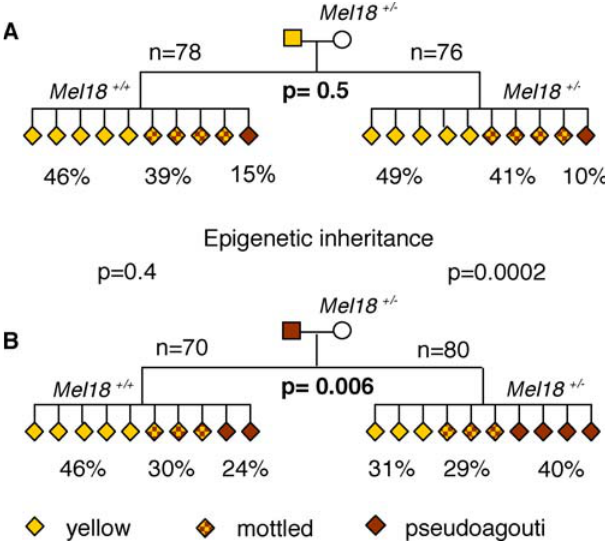
Figure 5. Pedigrees of Crosses between Mel18 þ / (cid:1) and Mice Carrying the A vy Allele A vy /a C57BL/6J sires of the indicated phenotype were mated with Mel18 þ / (cid:1) C57BL/6J dams. Data were produced from at least five different mating pairs in each case. Offspring not carrying the A vy allele have been omitted. All coat colour phenotypes were scored by one observer, before the analysis of Mel18 genotype. (A) There was no significant shift in the proportion of phenotypes observed between Mel18 þ / (cid:1) and Mel18 þ / þ littermates from yellow sires. (B) There was a significant shift towards the pseudoagouti phenotype in Mel18 þ / (cid:1) compared with Mel18 þ / þ littermates from pseudoagouti sires ( p ¼ 0.006). This shift produced a statistically significant difference in the range of Mel18 þ / (cid:1) offspring observed from yellow and pseudoagouti sires ( p ¼ 0.0002); the Mel18 þ / (cid:1) offspring of pseudoagouti sires are more likely to be pseudoagouti than those of yellow sires, i.e., transgenera- tional epigenetic inheritance is observed. Epigenetic inheritance was not observed in the Mel18 þ / þ littermates. DOI: